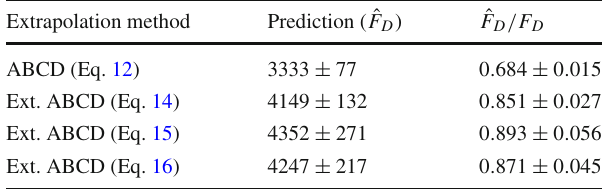
Table2 Predictionsofthenumberofeventsfor N j ≥ 9and N bj ≥ 4in t ¯ t + multijets samples using various extrapolation methods and ratios with respect to the true value (4874). The statistical uncertainties on the predictions are calculated from Poisson fluctuations of the control